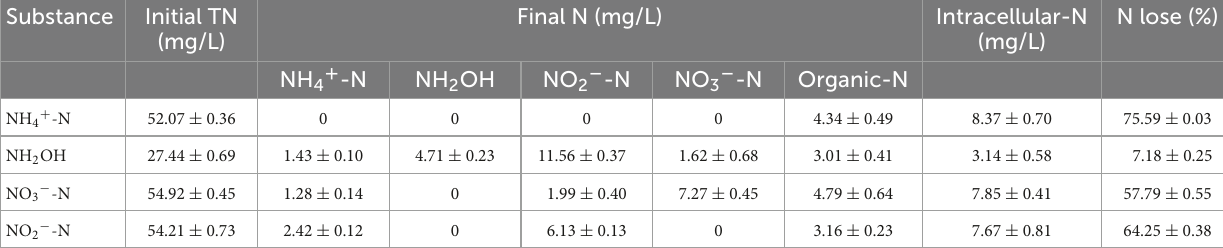
TABLE 1 Nitrogen balance during HN-AD